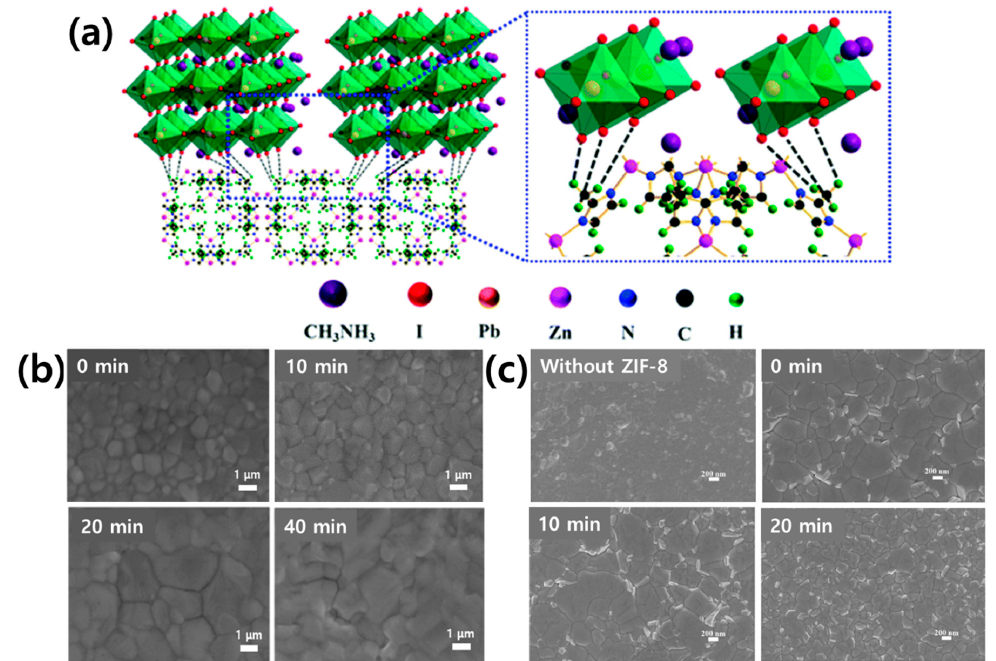
Figure 12. ( a ) Schematic of two neighboring grain structures crosslinked by the methyl groups in ZIF- 8. Reprinted from [173] with permission of The Royal Society of Chemistry. ( b ) SEM images of the MAPbI 3 -based layer formed on the surface of mp-TiO 2 with different ZIF-8 coating times: 0, 10, 20, and 40 min. Reprinted from [174] with permission. Copyright© 2015, WILEY. ( c ) SEM images of the perovskite films formed on c-TiO 2 and c-TiO 2 /ZIF-8 layers with different ZIF-8 synthesis times; 0, 10, and 20 min followed by ultrasonic vibration for 3 min. Reprinted from [175] with